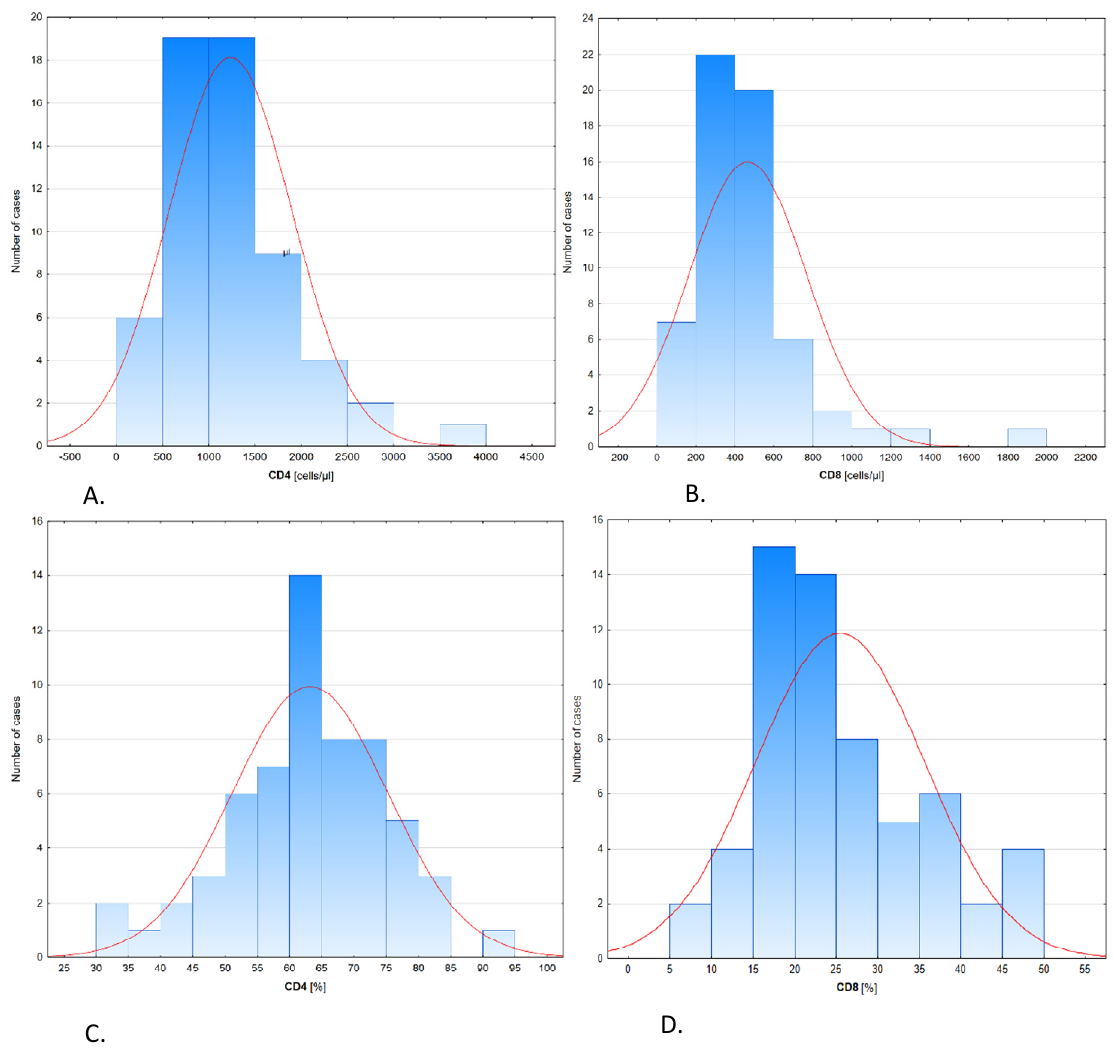
C. D. Figure 1. Distribution of lymphocyte subpopulations CD4+ and CD8+ in CIDP patients. Histograms of CD4+ lymphocytes ( A ), and CD8+ lymphocytes ( B ) in cells/ µ L, and % of CD4+ lymphocytes ( C ), and CD8+ lymphocytes ( D ). Table 3. Mean values and standard deviations of cytokines in the patient and control